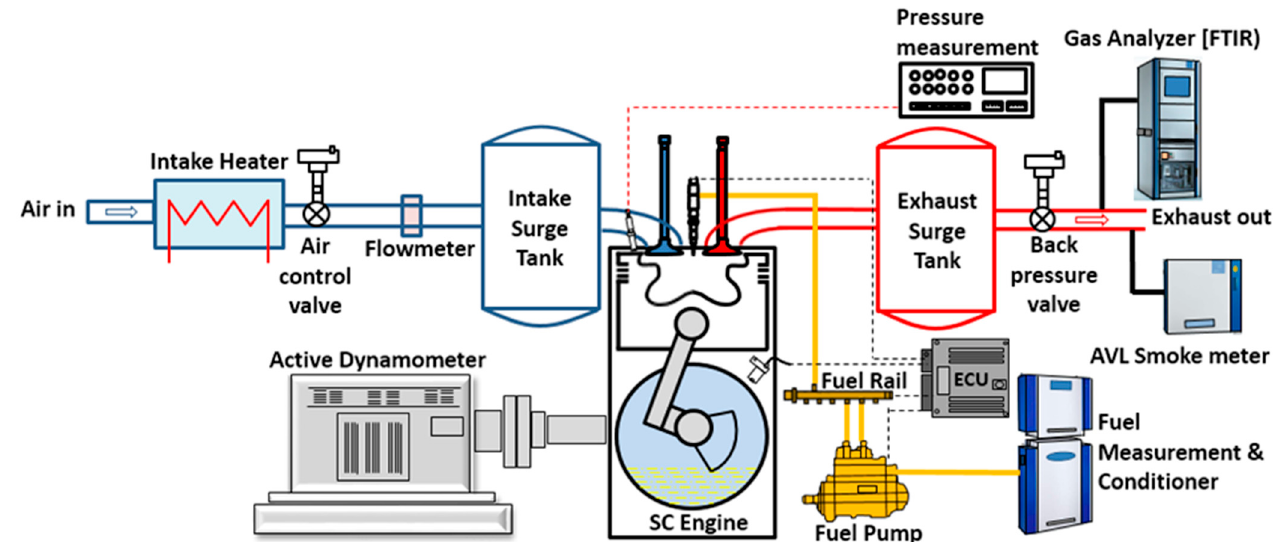
Figure 2. Overall layout of the single-cylinder research engine test-bench.